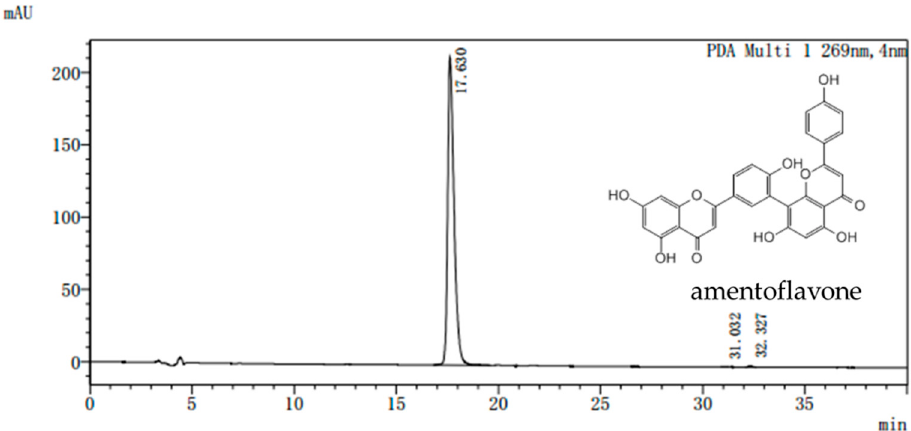
Figure 7. Representative high performance liquid chromatography (HPLC) chromatogram of amentoflavone. Waters Alliance 2695 separations module equipped with empower software hyphened with quaternary pumps, an automatic injector, a Waters 2998 photodiode array (PDA) detector at 190–800 nm, and a 250 mm × 4.6 mm × 5 μ m Platisil ODS C18 column was used for separation. HPLC analysis conditions: 40% ( v / v ) acetonitrile /water run for 20 min, the conditions were maintained at 40% ( v / v ) acetonitrile /water and returned to 80% ( v / v ) acetonitrile /water from 20 to 40 min. flow velocity: 0.8mL/min, wavelength of detection: 269nm; column temperature: 40 °C.